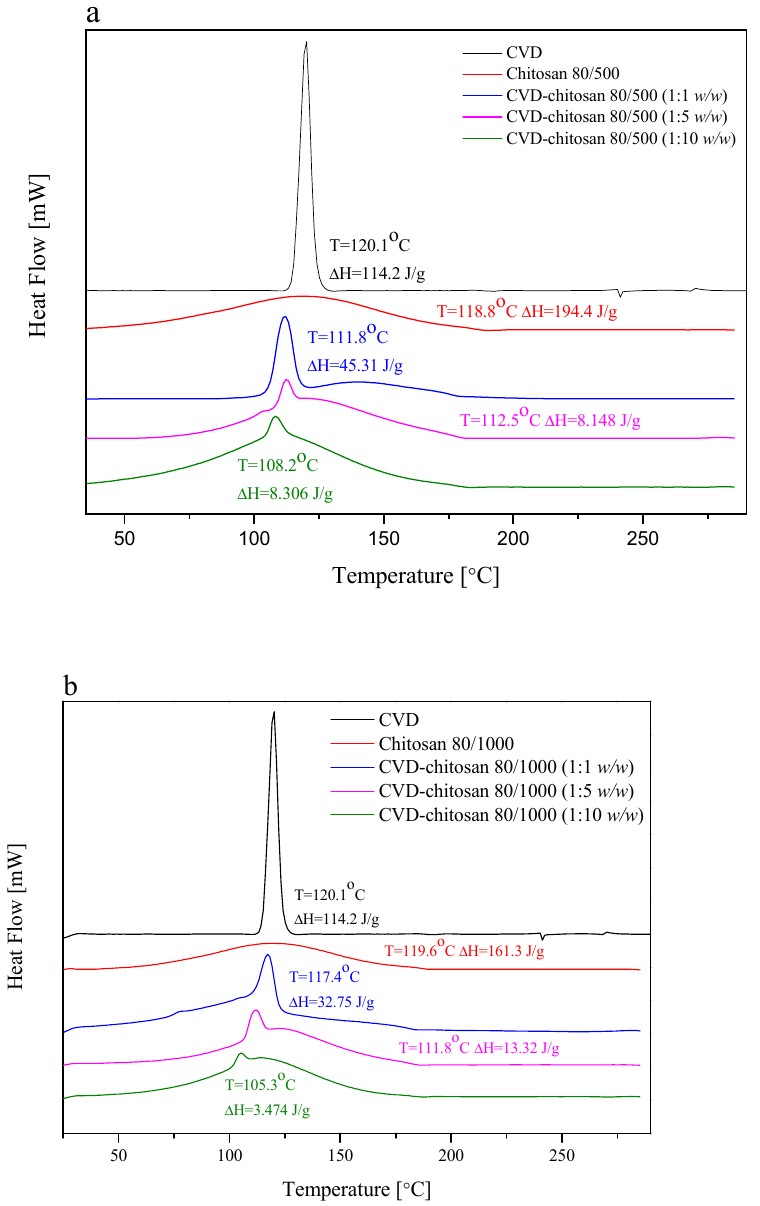
Figure 4. DSC thermograms of the solid systems of: CVD-chitosan 80/500 ( a ) and CVD-chitosan 80/1000 ( b ).